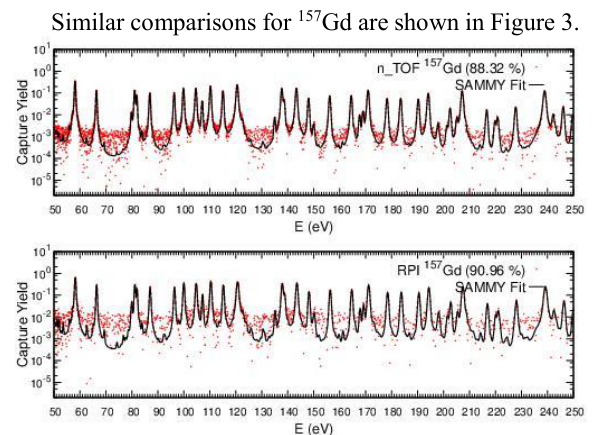
Fig. 3. Comparisons of SAMMY calculations with the resonance parameter (solid line) of the capture yield of the n_TOF and RPI data in the energy region 50 eV to 250 keV for 157 Gd.